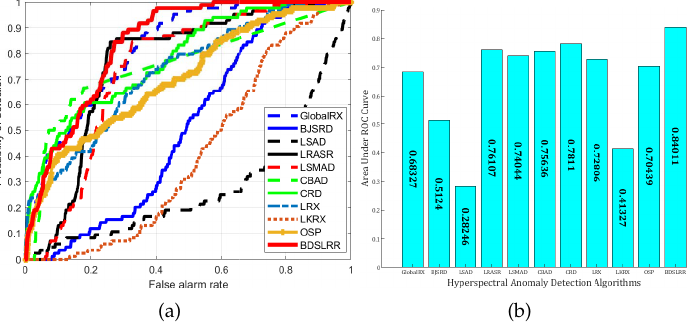
Figure 23. Detection accuracy evaluation for the Target Detection Blind Test dataset. ( a ) ROC curves; ( b ) AUC values.